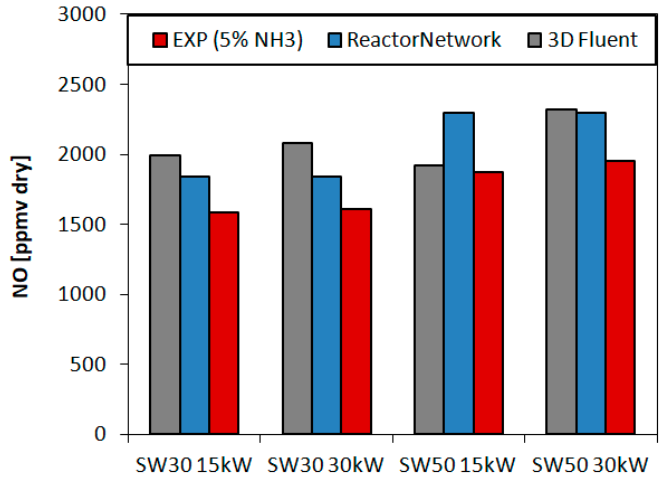
Figure 9. Comparison of the experimental and numerical NO emission at the outlet for the different swirlers and thermal load, ϕ = 0.71, mechanism Xiao.